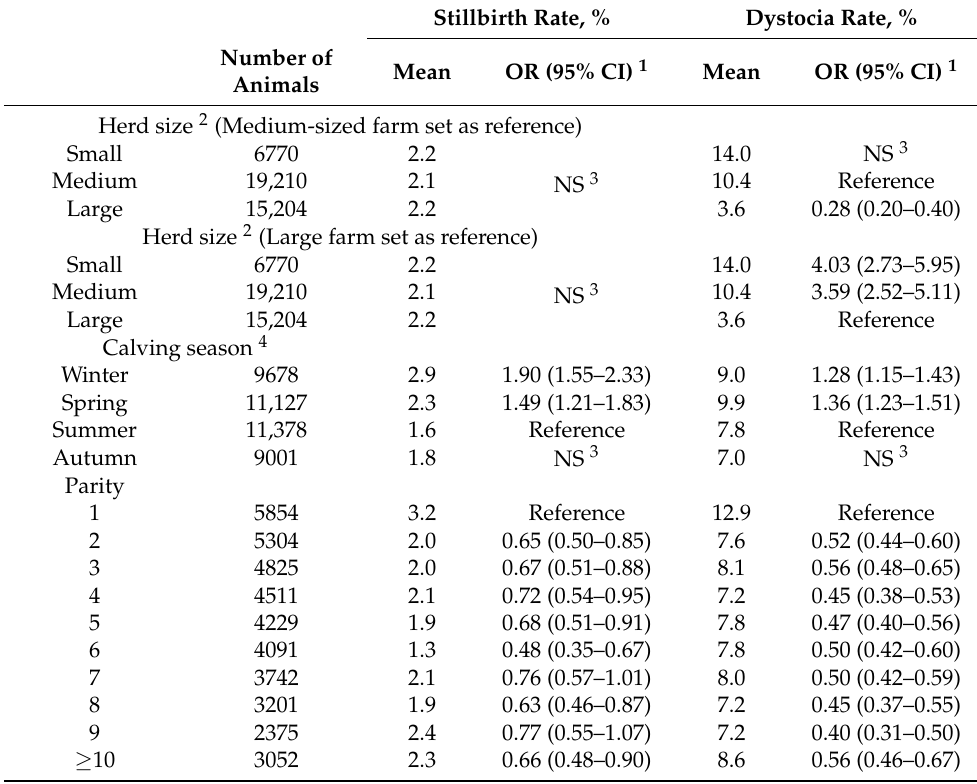
Table 1. Stillbirth and dystocia rate by herd size, season, parity, and gestation length. Stillbirth Rate,